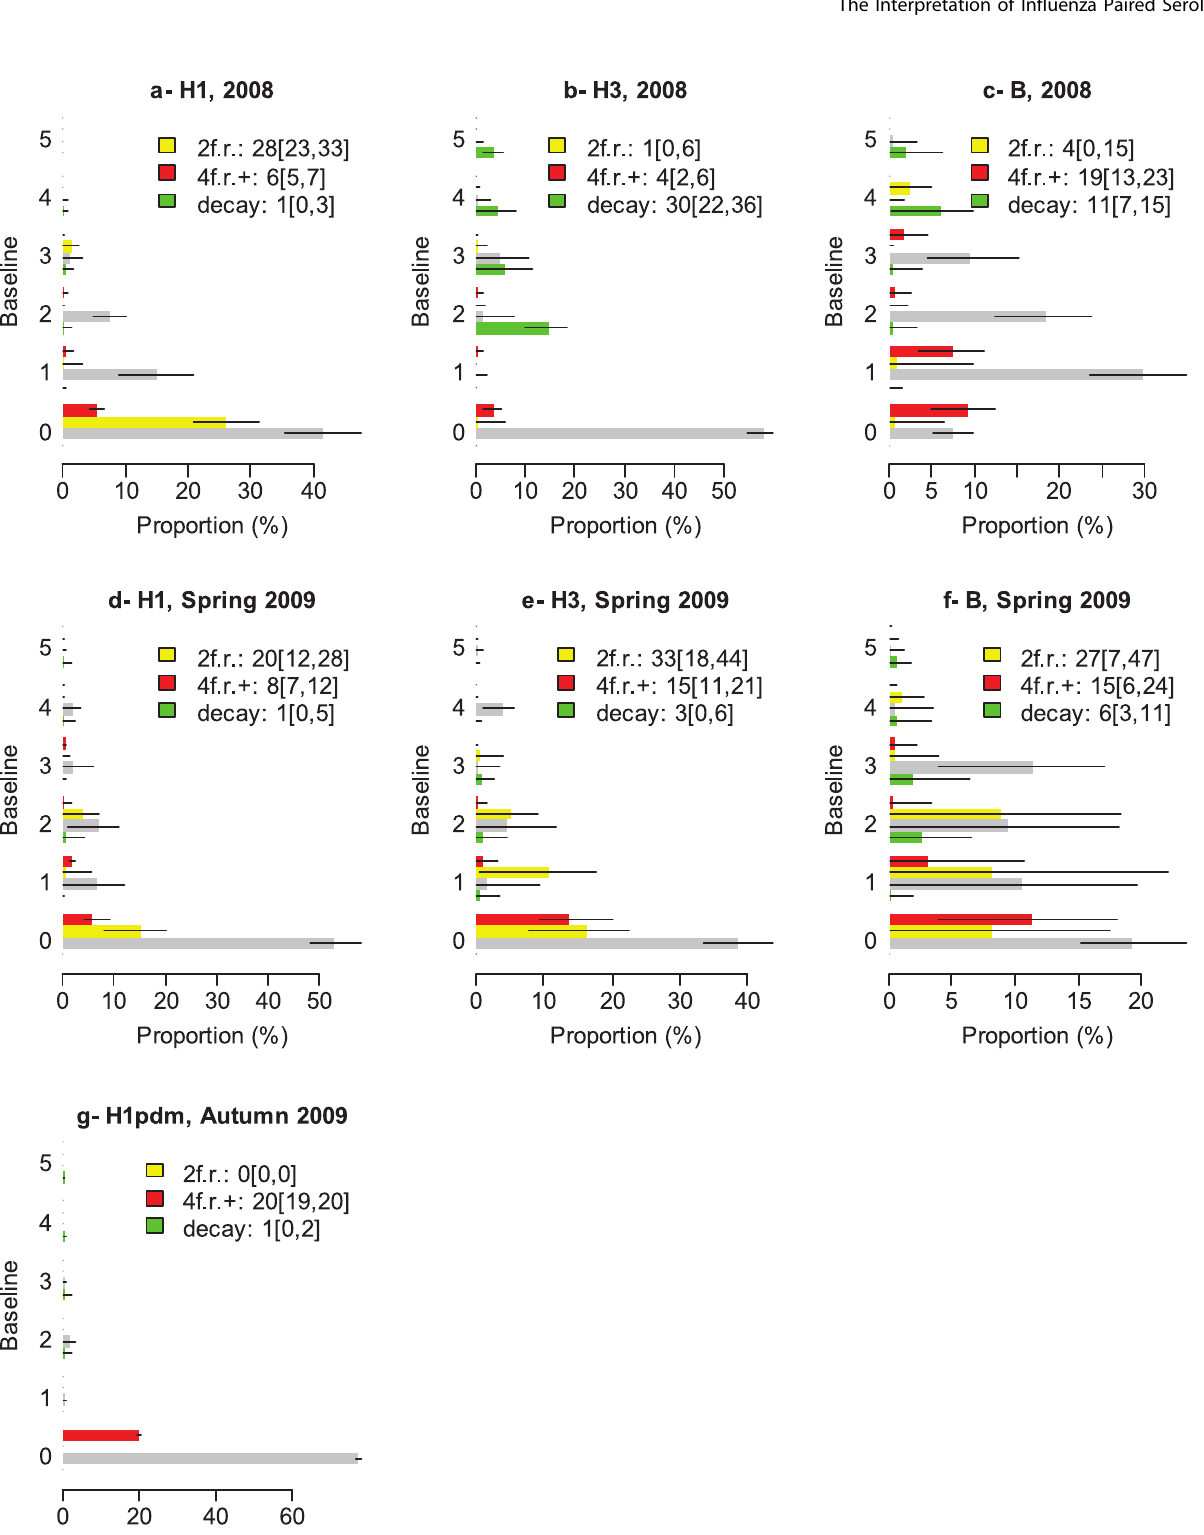
PLOS Pathogens | www.plospathogens.org